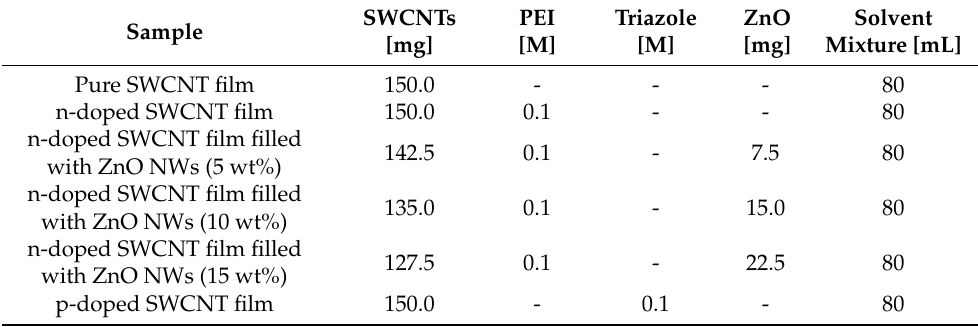
Figure 1. Assembly and doping of SWCNT films for thermoelectric applications. Table 1. Composition of the mixtures used to form SWCNT films in this study.